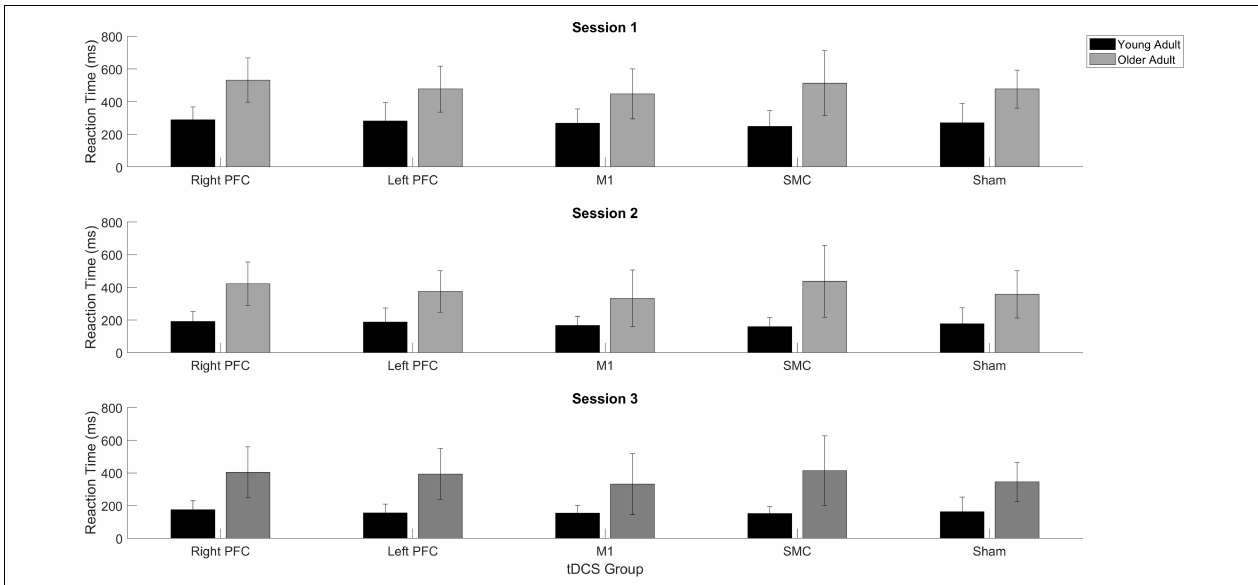
FIGURE 5 | Number of chunks for young and older adults as a function of trial number. Number of chunks were binned across every eight trials. Each panel represents a tDCS stimulation location and sham group for reference. Top left panel depicts young (black) and older (gray) adults in the right prefrontal cortex (PFC) tDCS groups as well as young (black with squares) and older (gray with squares) sham groups. Top right panel depicts young (black) and older (gray) adults in the left PFC tDCS groups as well as sham (squares). Bottom left panel depicts young (black) and older (gray) adults primary motor cortex (M1) tDCS groups. Bottom right panel depicts young (black) and older (gray) adults in the supplementary motor complex (SMC) tDCS